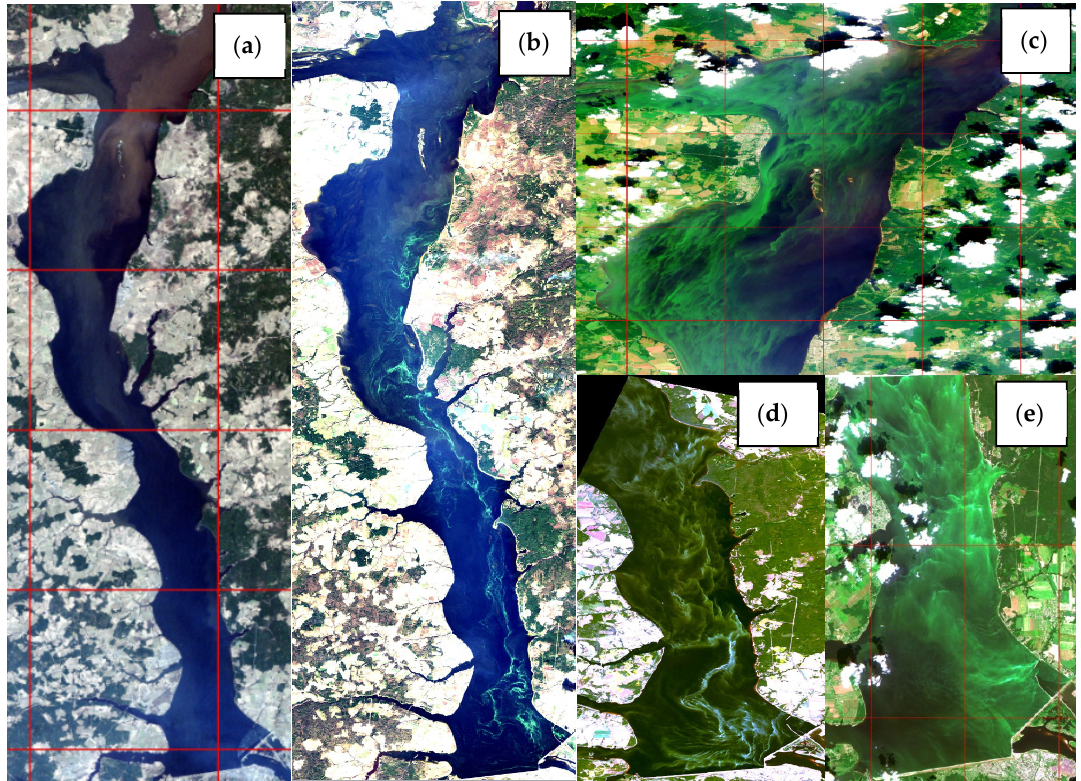
Figure 2. Examples of the spatiotemporal distribution of algal bloom and mineral suspended matter in the Gorky Reservoir: ( a ) Landsat 7 (5 May 2009), ( b ) Landsat 8 (21 October 2015), ( c ) Sentinel-2A (25 July 2016), ( d ) Landsat 8 (1 September 2017), and ( e ) Sentinel-2A (15 July 2016).